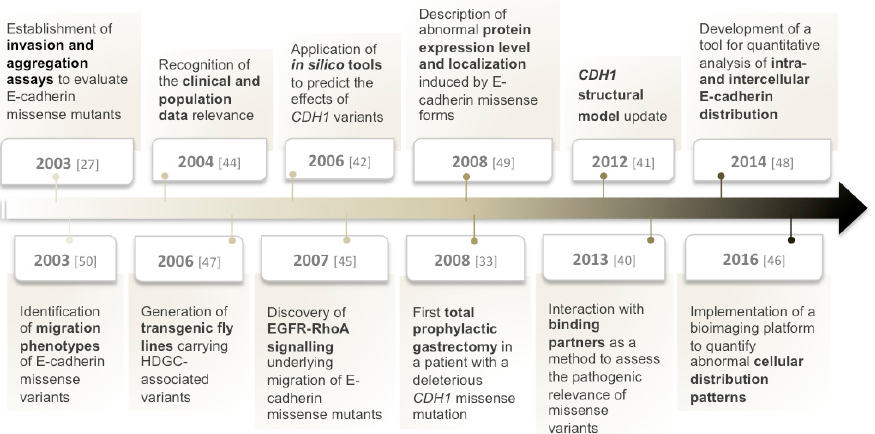
Figure 1. Timeline with the key findings and technological developments important to evaluate the pathogenicity of CDH1 germline missense variants, in the context of Hereditary Diffuse Gastric Cancer (HDGC) [27,33,40–42,44–50].